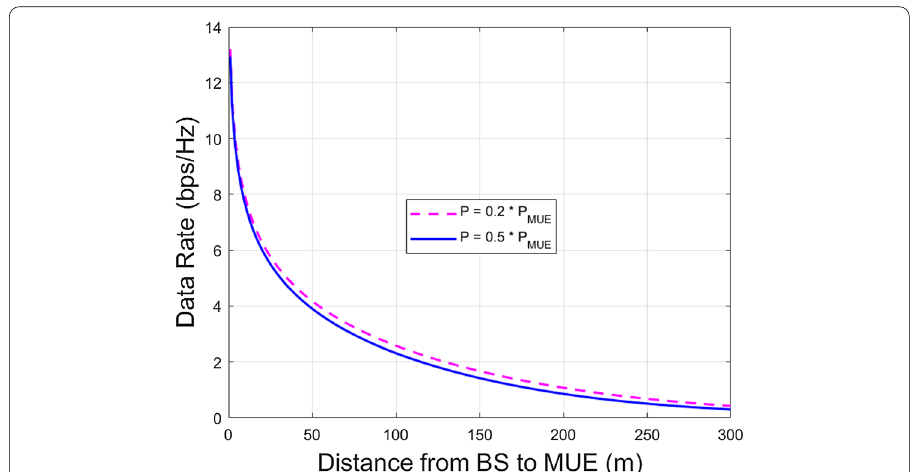
Fig. 4 Data rate vs. distance from BS to MUE in downlink